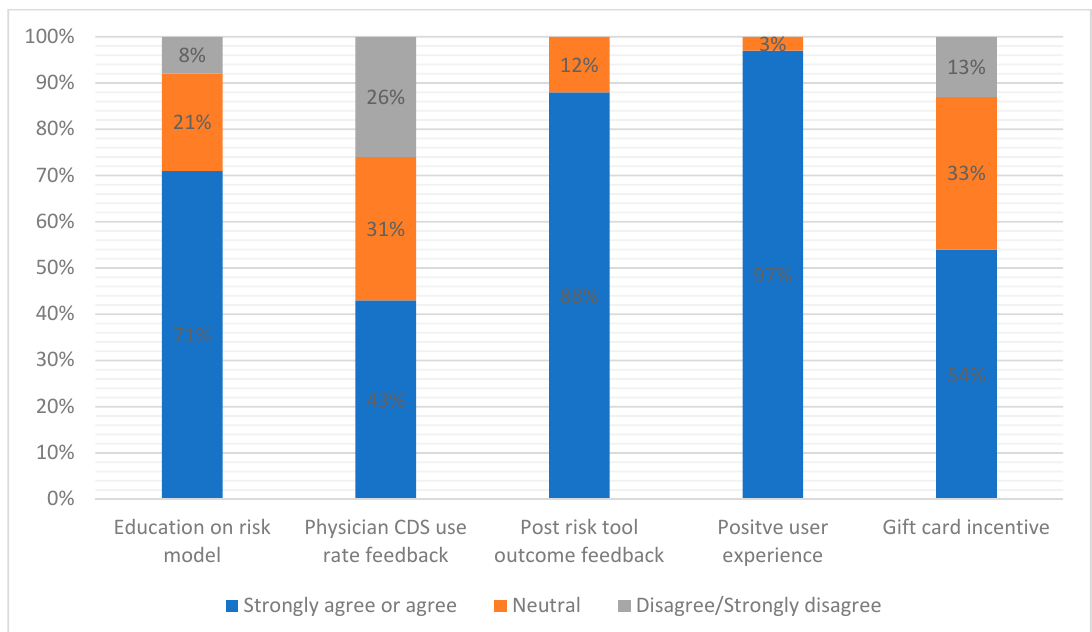
Figure 2. Survey data: ED providers’ impressions of key factors that would influence their likelihood of using an ML-based AHF risk model and paired CDS. Bars represent percentage of providers responding “agree/strongly agree”, “neutral”, or “disagree/strongly agree” to each potential motivator of use.